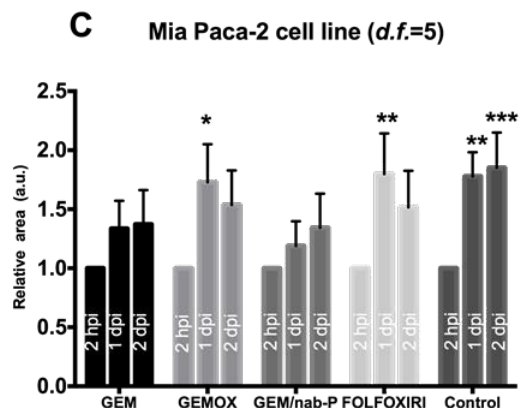
Figure 3. Efficacy analysis. Evaluation of the effects of chemotherapy on cancer cell lines (HCT 116, MIA PaCa-2) xenotransplanted in 2 dpf zebrafish embryos. Each embryo was imaged at 2 hpi, 1 dpi, 2 dpi and the relative area is the Dil-stained area normalized with respect to the 2 hpi time point. ( A ) Chemosensitivity of HCT 116 xenografts, d.f. = 8. A statistically significant increase in relative area